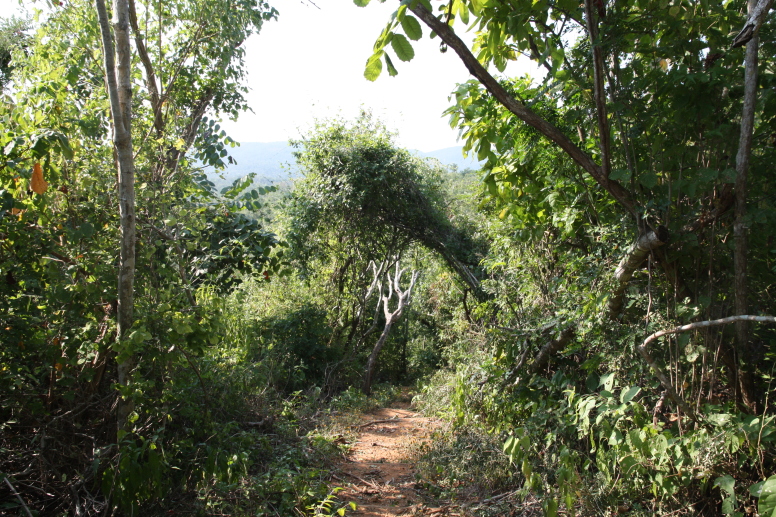
Brachypelma
klaasi habitat, subtropical deciduous forest, near Chamela, Jalisco state, Mexico. Photo: Stuart J. Longhorn.